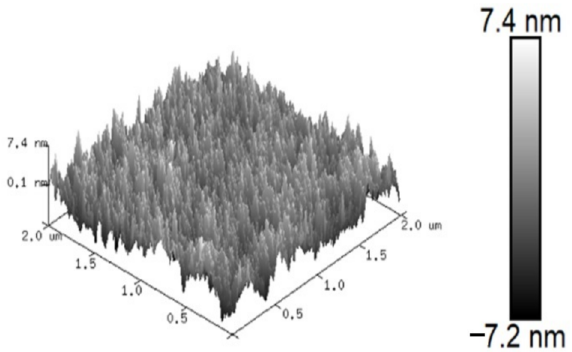
Figure 5. The AFM 3D micrograph of the thin film a deposited at 25 ◦ C for 60 min with 65 W. The roughness value of film a is 1.68